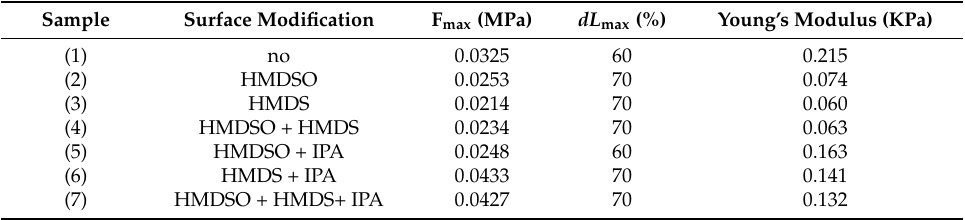
Figure 7. ( a ) Digital camera images of flexible MSQ aerogels before and after stressed; ( b ) Stress-strain curves of flexible MSQ aerogels with different surface modifications. Table 2. Maximum strain, maximum stress and young modulus of flexible MSQ aerogels.